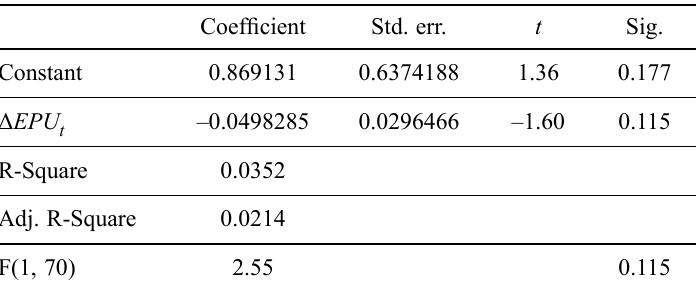
Table 5. Regression results obtained from Equation